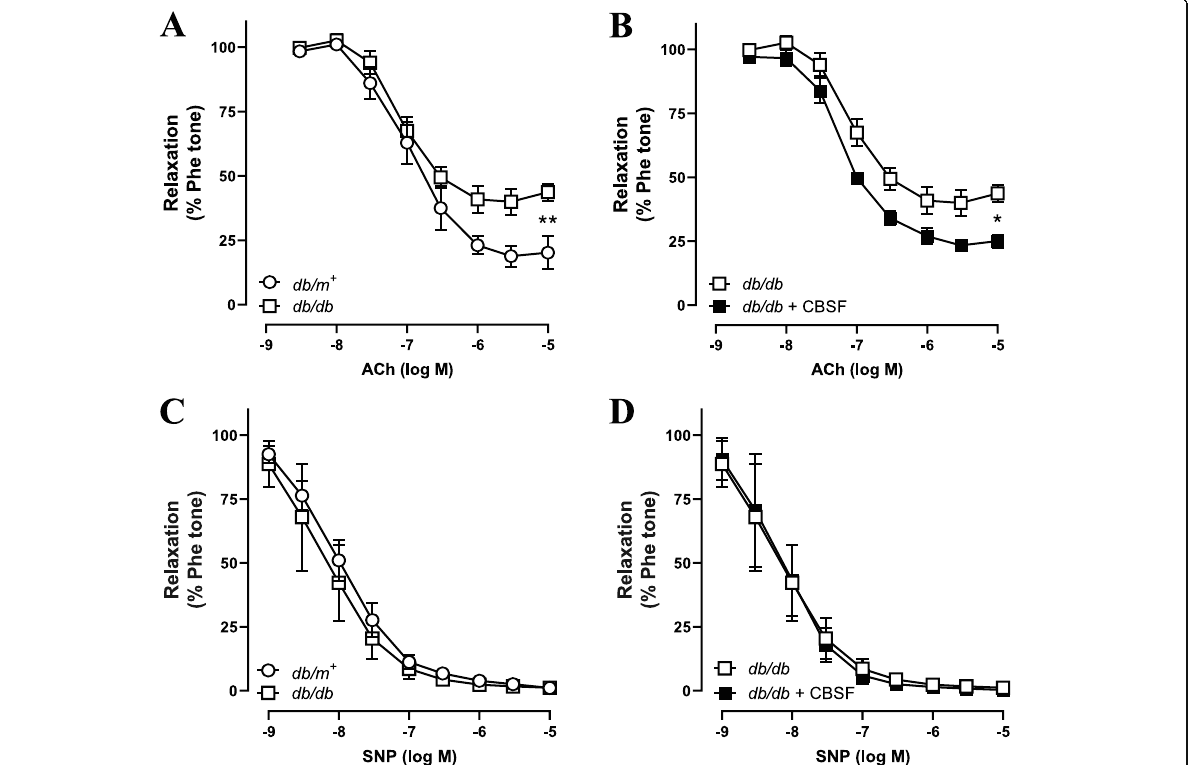
Fig. 3 Ex vivo CBSF incubation ameliorated the impaired EDR in db/db mouse aortae. EDR measured by wire myograph in non-treated db/m + and db/ db mice ( a ). Effect of ex vivo CBSF incubation on EDR in isolated aortae from non-treated db/db mice ( b ). Effect of ex vivo CBSF incubation on endothelium-independent relaxation in isolated aortae from non-treated db/m + and db/db mice ( c-d ). Data are presented in means ± SEM; n =3 for db/m+ , n =5 for db/db ; * p <0.05, ** p <0.01. CBSF, crocodile blood soluble fraction; Phe, phenylephrine; ACh, acetylcholine; SNP, sodium